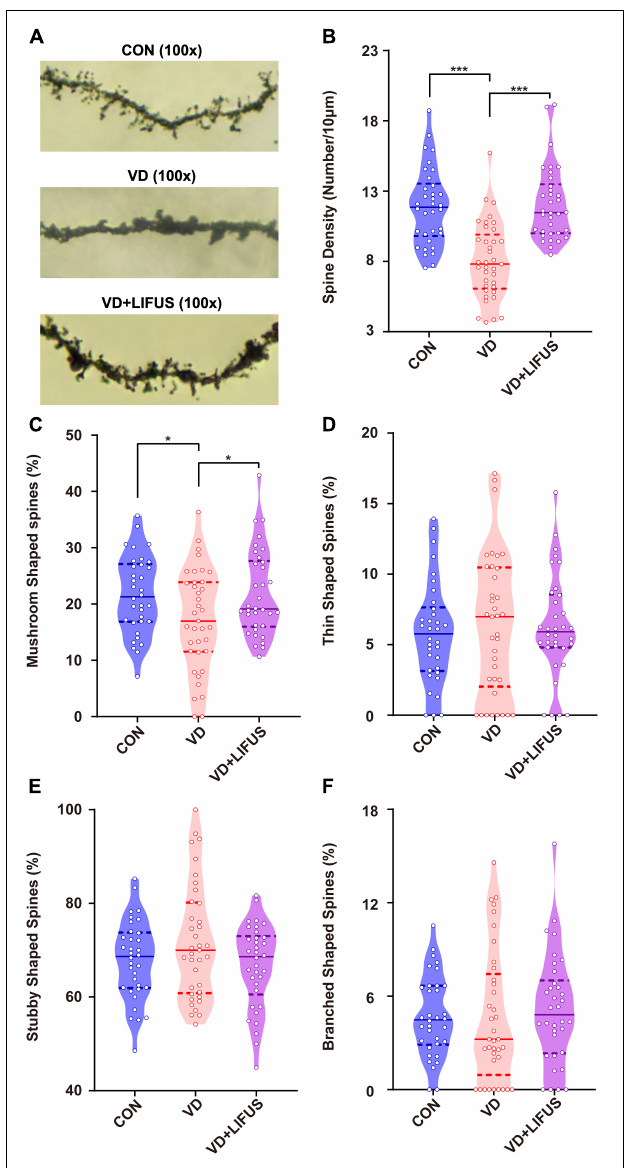
FIGURE 5 | Effect of LIFUS on the density of dendritic spines. (A) Typical diagrams of Golgi-cox staining in three groups. (B) The spine density in three groups. (C–F) The percentage of the mushroom shaped spines, thin shaped spines, stubby shaped spines, and branched shaped spines. Data are expressed as mean ± SEM. * p < 0.05, *** p < 0.001 (CON, n = 6; VD, n = 4; VD + LIFUS, n = 4).